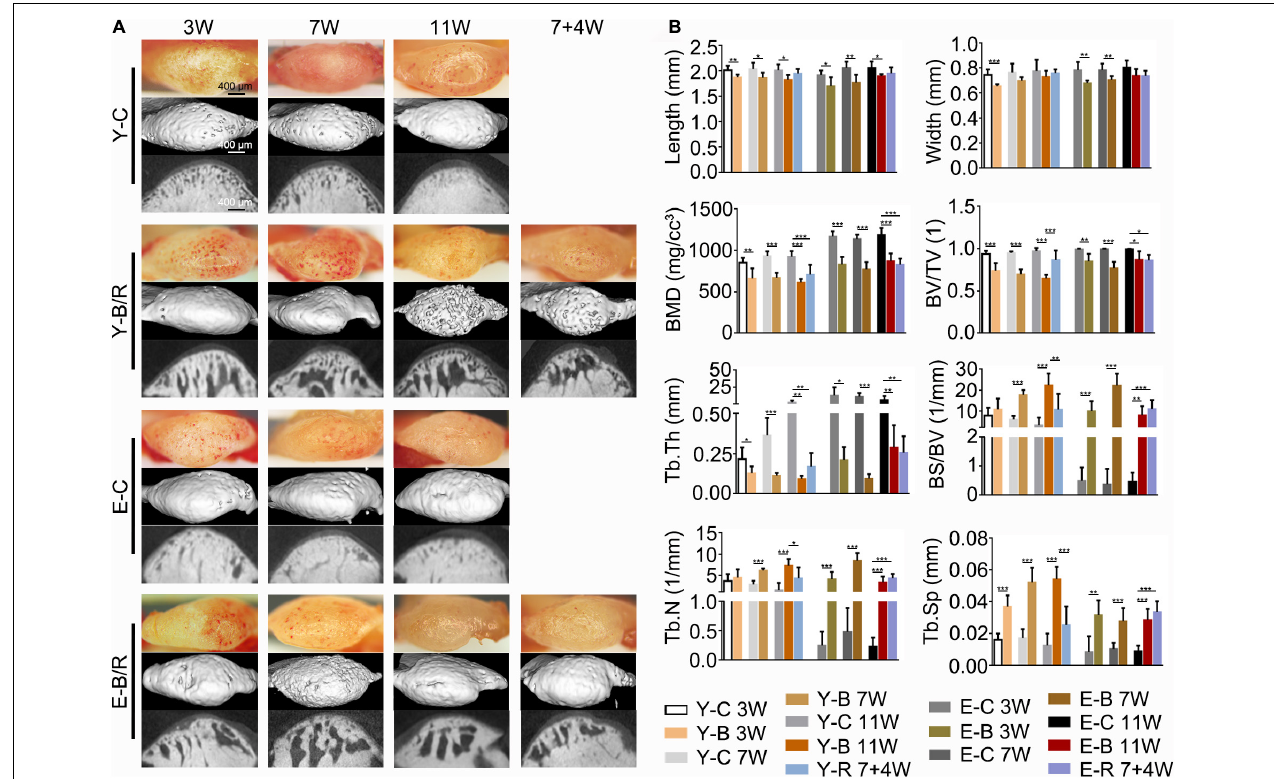
FIGURE 3 | (A) Representative gross morphology (bars = 400 µ m) and the micro-CT images (bars = 400 µ m) of the mandibular condyles. (B) Comparisons of the measured parameters as indicated between the BAC groups and the age-matched control groups. Data are presented as mean ± SD. Unpaired t -test was used for comparisons between the age-matched control and BAC groups. One-way ANOVA was used for comparisons among the age-matched control, BAC, and BAC removal groups. n = 6. * P < 0.05; ** P < 0.01 and *** P < 0.001 for the differences between all BAC and removal groups and the age-matched control groups. BMD, bone mineral density; BV/TV, the ratio of bone volume to tissue volume; Tb.Th, trabecular thickness; BS/BV, the ratio of bone surface area to bone volume; Tb.N, trabecular number; Tb.Sp, trabecular separation. For the grouping and time points, please refer to Figure 1A